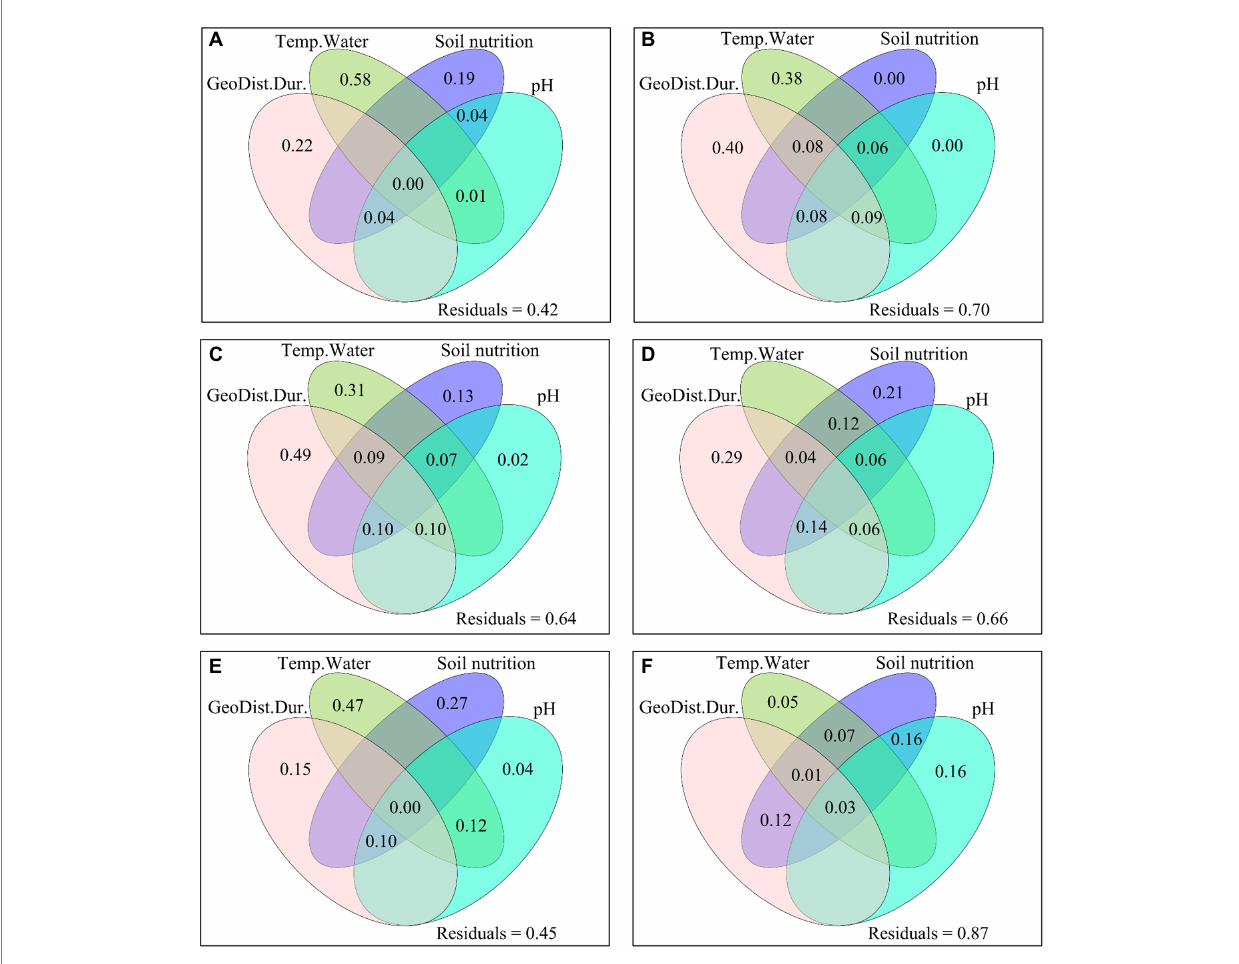
FIGURE 3 The excluded and interactive impacts of GeoDist.Dur., the dissimilarity of Temp.Water, soil nutrition and pH on the dissimilarity of (A) species richness, (B) Shannon, (C) Simpson, (D) Pielou, (E) PD, and (F) MNTD between C4313 versus W4513, C4313 versus W4693, and C4513 versus W4693. PD: phylogenetic diversity; MNTD: mean nearest taxon distance; GeoDist.Dur.: geographic distance and warming duration; Temp.Water: soil and air temperatures, vapor pressure deficit and/or soil moisture; soil nutrition: available phosphorus, nitrate and ammonium nitrogen. C4313: non-warming plots at elevation 4,313 m; C4513: non-warming plots at elevation 4,513 m; W4513: warming plots at elevation 4,513 m; W4693: warming plots at elevation 4,693